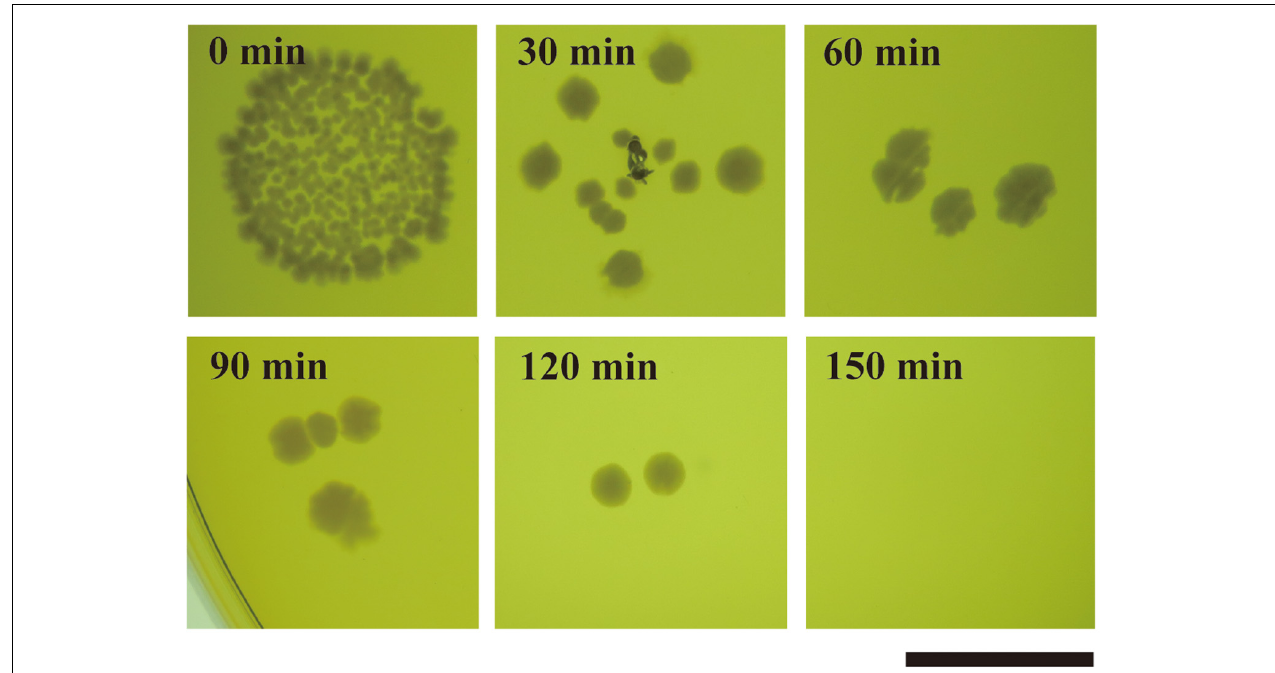
FIGURE 5 | Thermal resistance assay of L. paragasseri JCM 5343 T . Strain JCM 5343 T culture was heat treated at 85 ◦ C for 30–150 min (intervals of 30 min). After heat treatment, the resulting cultures were spotted on de Man-Rogosa-Sharpe medium (MRS) agar plates and incubated at 37 ◦ C under anaerobic conditions. Scale bar indicates 1